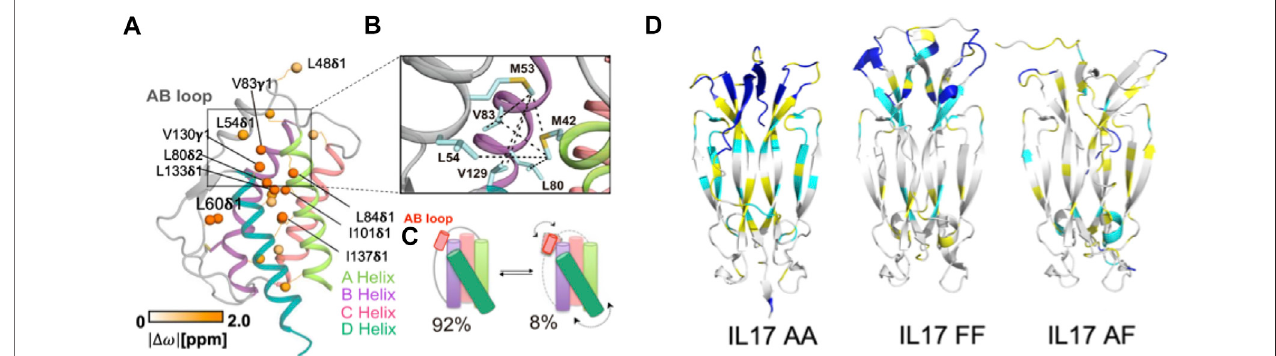
FIGURE 2 | Molecular insights from structure-function studies of interleukins. (A) Methyl side chains probed at carbons via C (Conlon et al., 2019) labeling in the coreofIL-2undergoingchemicalexchangeareshownasorangespheres. (B) Close-upviewoftheABloopshowinganetwork(dottedlines)ofobservedNOEsintheIL- 2 ground state, where the AB loop is well-packed against the hydrophobic core. (C) Schematic representation of IL-2 interconversion between ground state (92% population) and excited state (8% populated). Arrows represent concerted conformational changes in the AB loop and hydrophobic core. Figures 2A – C is reproduced with small orientational modi fi cations done in Procreate and PowerPoint from De Paula et al. (2020). (D) Cartoon representations of IL-17 in dimeric states, highlighting altered regions of dynamics. 15 N - 1 H HSQC NMR spectra collected of each IL-17 dimer were compared and regions with differences in backbone amide peak intensities were mapped onto the structure. Residues highlighted in cyan display signi fi cantly decreased peak intensities or give rise to double resonances, suggesting highly dynamic sites. Residues highlighted in yellow are amino acids for which peak intensity could not be determined based on spectral overlap, while residueshighlightedinblueareunassigned. Figure2D isreprintedfromCytokinevol.142,Watersetal., “ Conformationaldynamicsininterleukin17Aand17Ffunctional complexes is a key determinant of receptor A af fi nity and speci fi city. ” 2021. With permission from Elsevier.